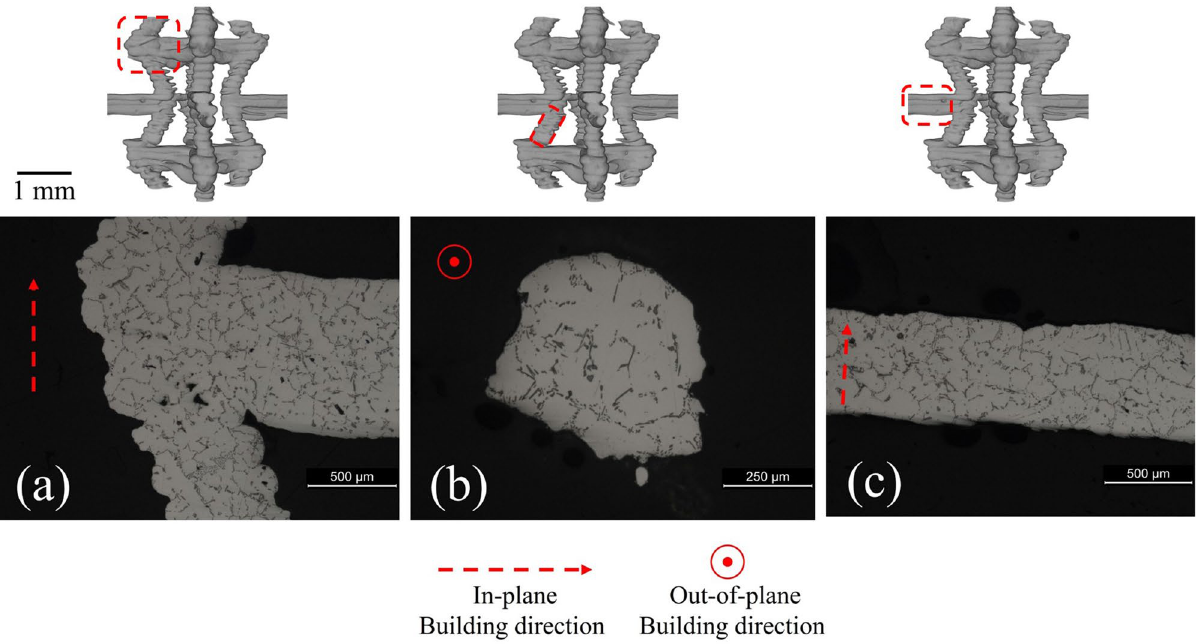
Figure 5. Representative optical micrographs of polished sections for a representative cell showing ( a ) a corner, ( b ) a vertical strut and ( c ) a horizontal rib.